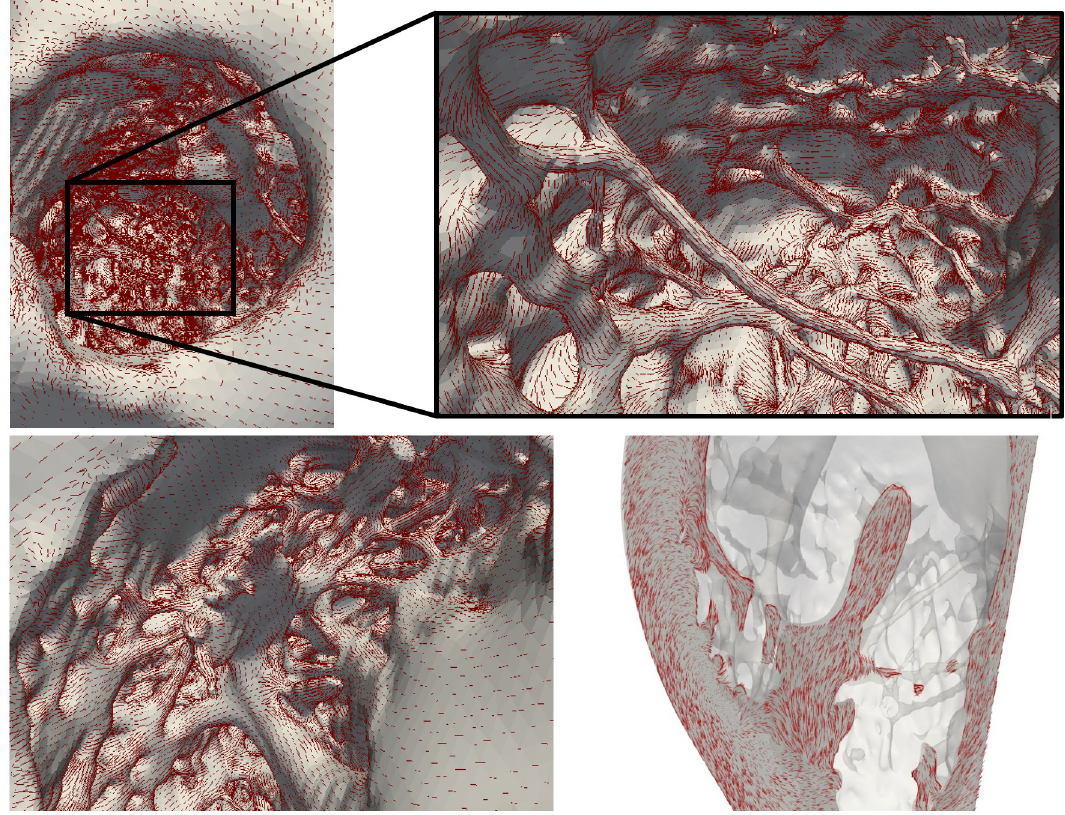
Fig 3. Illustration of the level of detail in the models (geometry A) with fibers, represented by red lines, overlayed. Top : Left ventricular endocardium with focus on the longest false tendon. Bottom : Right ventricular endocardium. The fiber transition between the trabeculae and papillary muscle is observed in the right